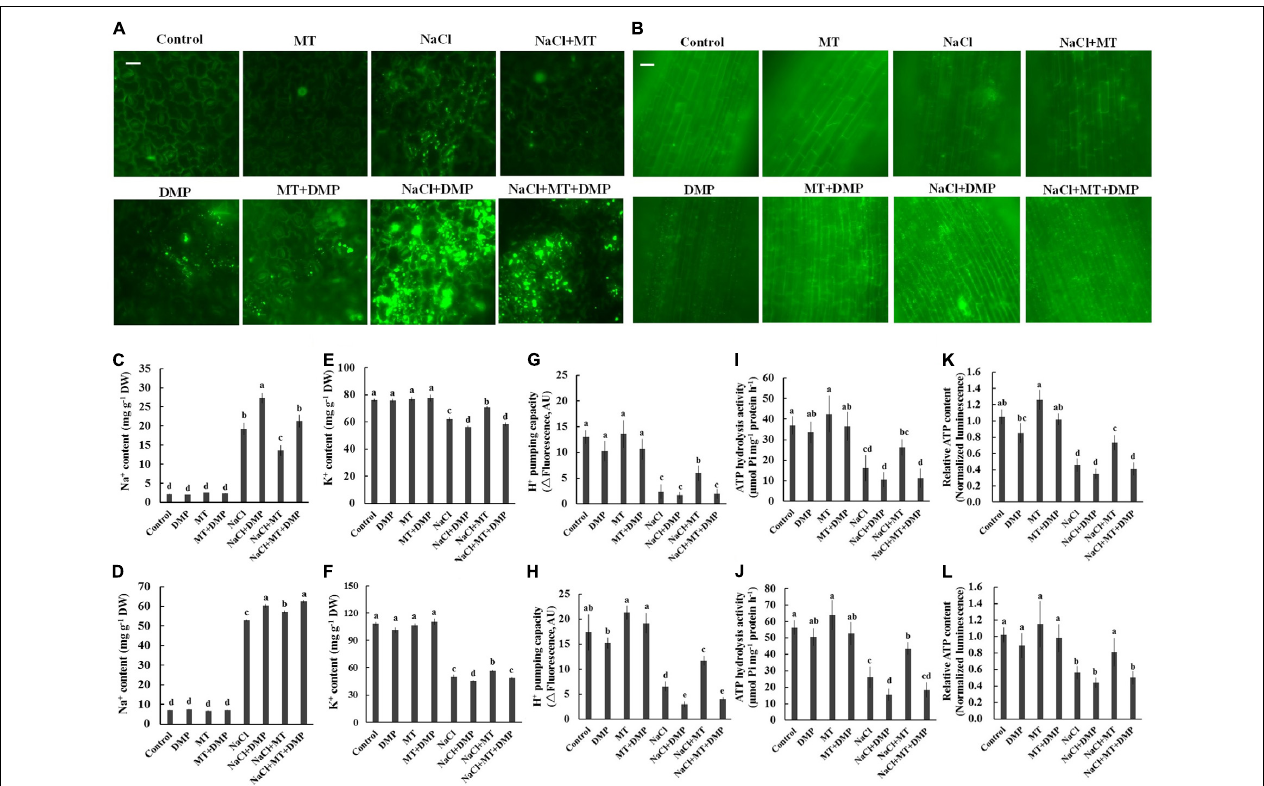
FIGURE 7 | DMP reversed the effects of MT on the TAG accumulation, K + and Na + content, PM H + –ATPase activity, and cellular ATP level in NaCl-stressed Xu 32. Xu 32 seedlings were pretreated with 0.5 µ M (root) + 100 µ M (leaf) MT for 3 days and then subjected to NaCl (150 mM) plus DMP (25 µ M) treatment. (A,B) Mature leaves and fine roots were collected from various treatment groups (5 days after treatment), stained with BODIPY 493/503 and then observed under a fluorescence microscope. For each treatment, a minimum of 10 root segments and leaf disks from four individual plants was observed. Representative images showing the alteration of lipid droplet accumulation. (C–F) Na + and K + content in the leaves (C,E) and roots (D,F) of Xu 32 under various treatment conditions (7 days after treatment). Columns represent the means of five repetitions, whereas bars represent the standard error of the mean. (G–J) H + pumping and ATP hydrolysis activity in PM vesicles purified from the leaves (G,I) and roots (H,J) of Xu 32 under different conditions (5 days after treatment). Each column is the mean of three independent experiments. (K,L) Relative ATP level in the leaves (K) and roots (L) of Xu 32 under different conditions (5 days after treatment). Each column is the mean of six repetitions. Columns labeled with different letters indicate significant difference at P <